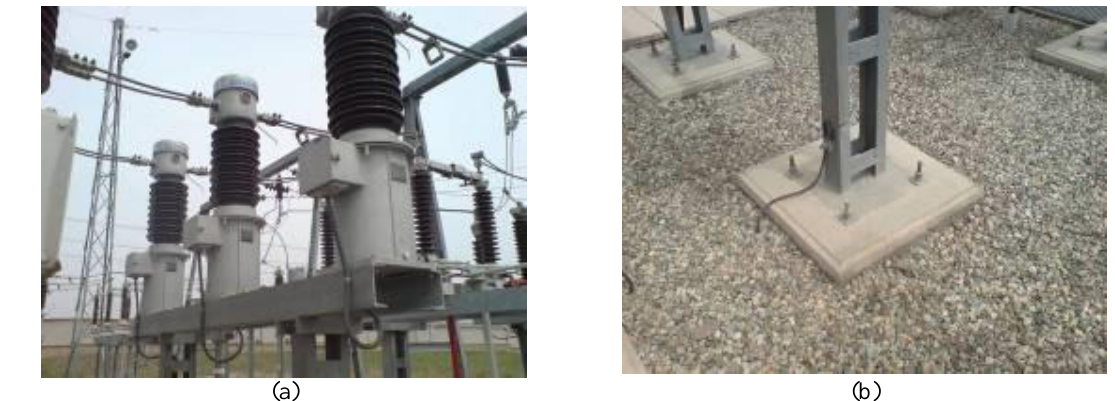
Figure 8. (a) Current transformer of 63 KV substation of Minoodar, and (b) The connections of current transformer of 63 KV substation of Minoodar Seismicity of the region